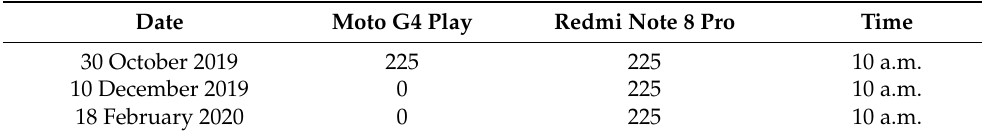
Figure 2. Location of the study area and image of the Embrapa Beef Cattle. Table 1. Images collected with each mobile phone at P7.